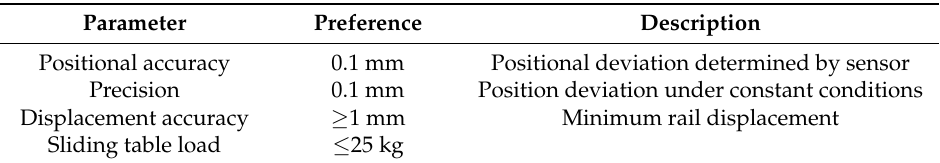
Table 1. Linear System Parameters.